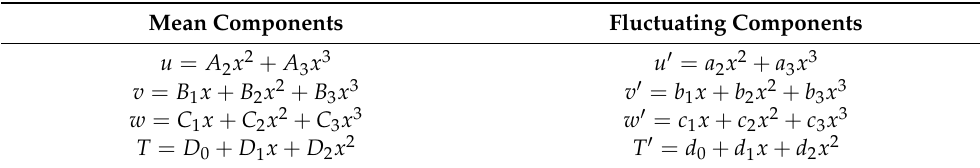
u (cid:48) , mean temperature T , and fluctuating temperature T (cid:48) i